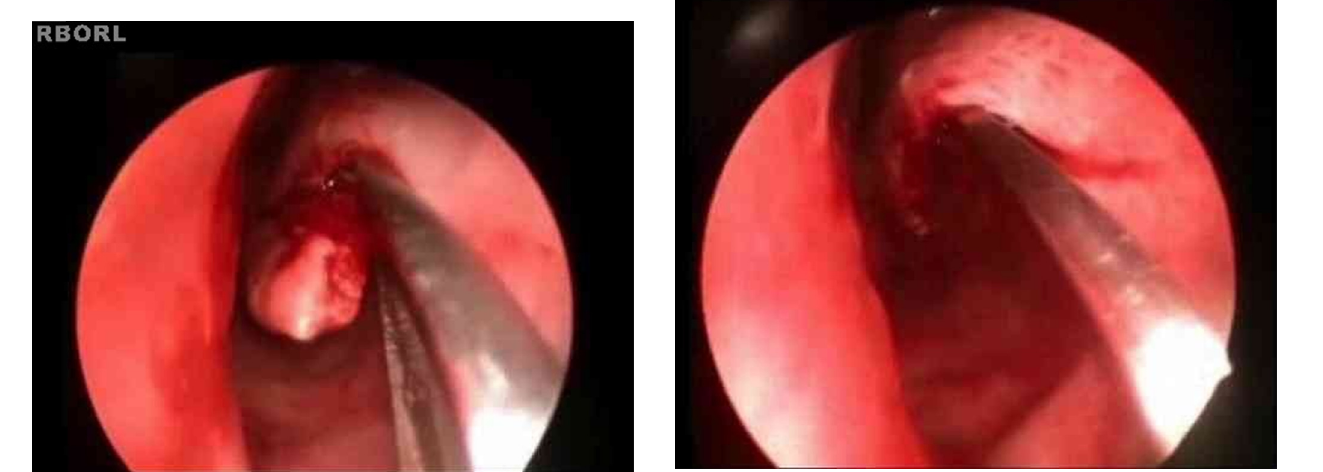
Figure 2 Direction of the turbinectomy scissors blades.